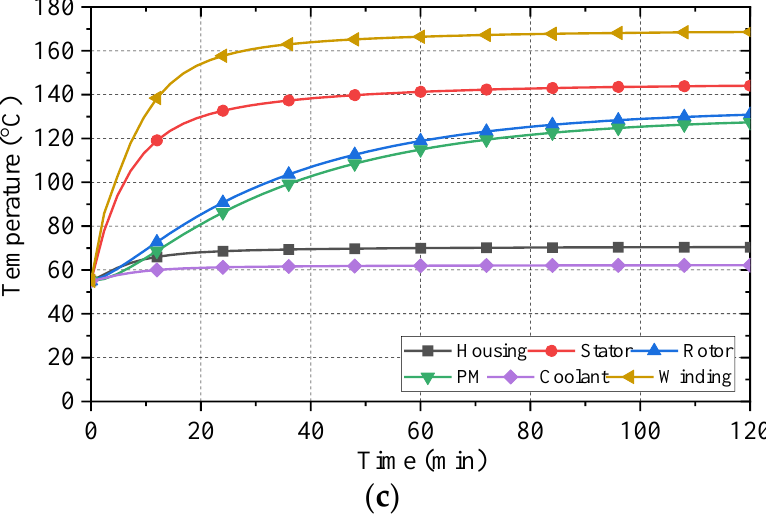
Figure 7. The transient temperature under three typical operating conditions calculated using the CFD method. ( a ) 1500 r/min @ 130 kW. ( b ) 796 r/min @ 200 kW. ( c ) 2700 r/min @ 130 kW.